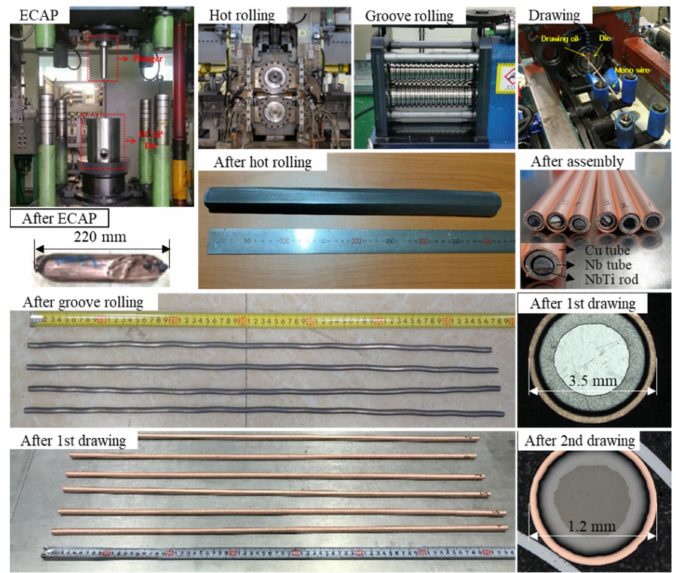
Figure 2. Photos depicting the various equipment for ECAP, hot rolling, groove rolling and drawing, and experimental results showing the prepared specimen and its